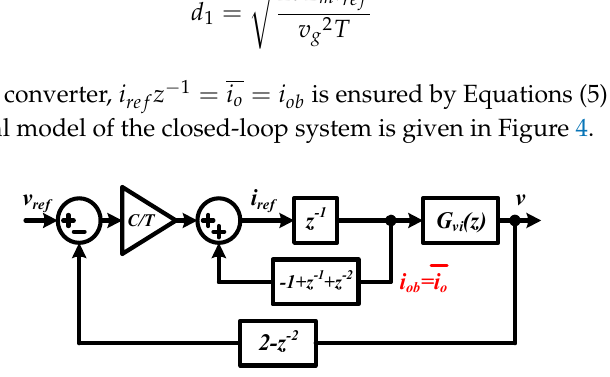
Figure 4. Ideal discrete-time small signal model of SCB controlled flyback converter.